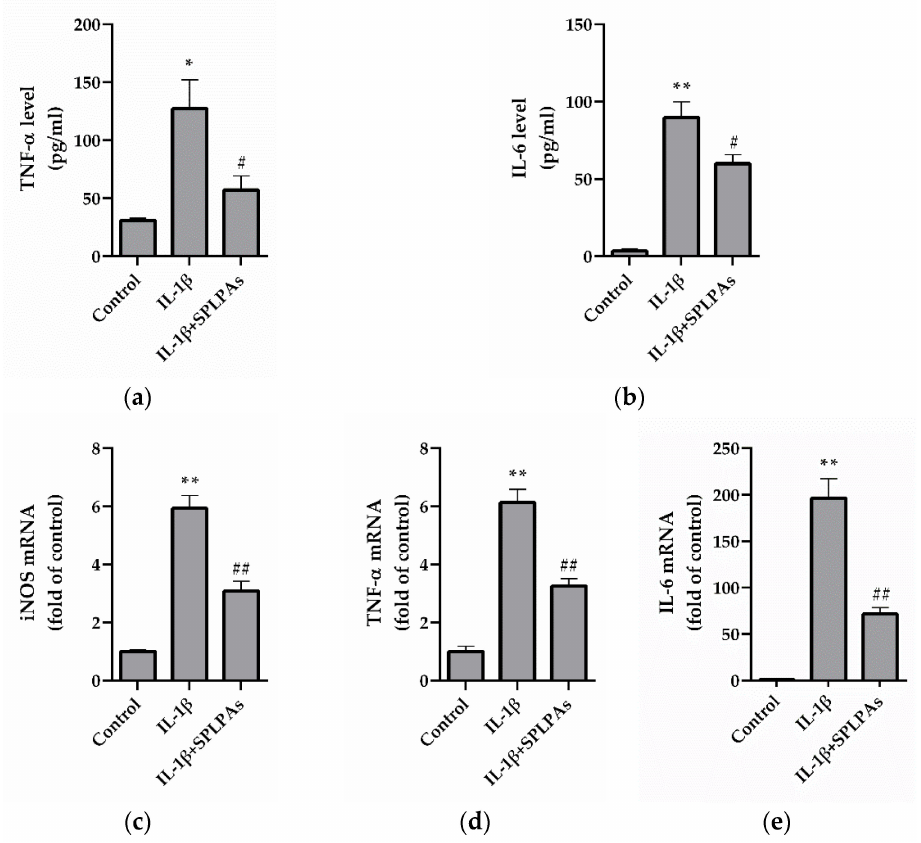
Figure 3. The influence of SPLPA extract on other inflammatory mediators by ELISA and Quantitative Real-time qPCR analyses. ( a , b ): Effect of SPLPA extract on the level of TNF- α and IL-6 at 0.2 mg/mL. ( c – e ): Effect of SPLPAs extract on the mRNA levels of iNOS, TNF- α , and IL-6 at 0.2 mg/mL. * p < 0.05 and ** p < 0.01 vs. the control group; # p < 0.05 and ## p < 0.01 vs. the IL-1 β (10 ng/mL) group. Inflammation-related nitric oxide synthase (iNOS), an isoform of nitric oxide synthase, is known to regulate the generation of NO in cells, and the mRNA level of iNOS was detected by qPCR. As shown in Figure 3c, the increased mRNA level of iNOS after IL-1